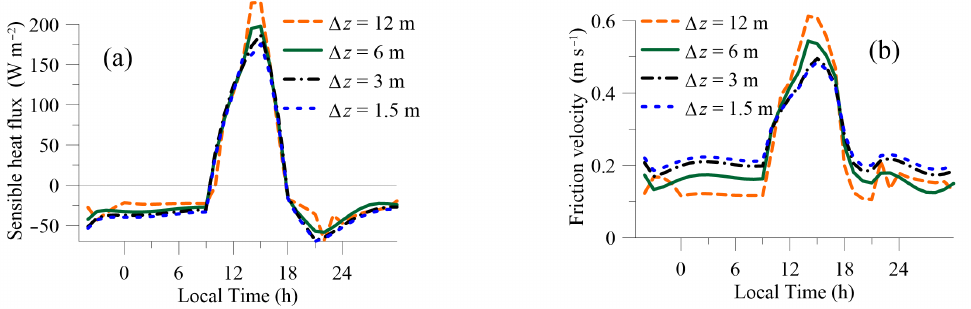
Figure 5. The results of grid sensitivity test of Model 1: ( a ) Sensible heat flux. ( b ) Friction